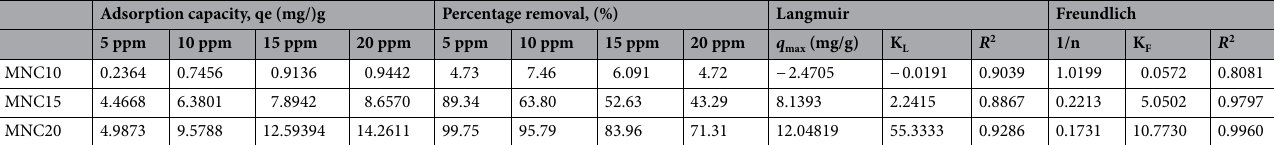
Adsorption capacity, qe (mg/)g Percentage removal, (%)